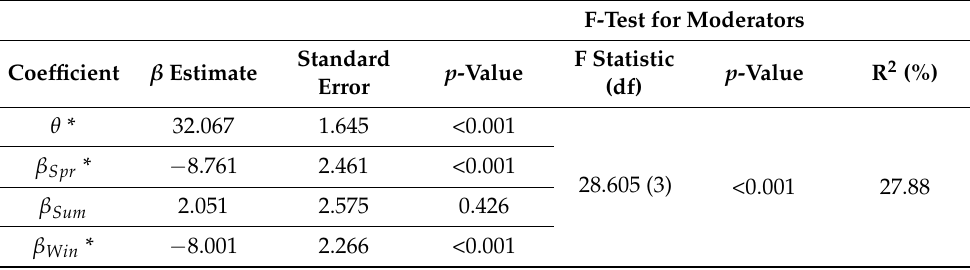
Table 3. Multivariate regression investigating the significance of season as a predictor of vitamin D levels. * = predictors with significant ( p < 0.05) β -coefficient.